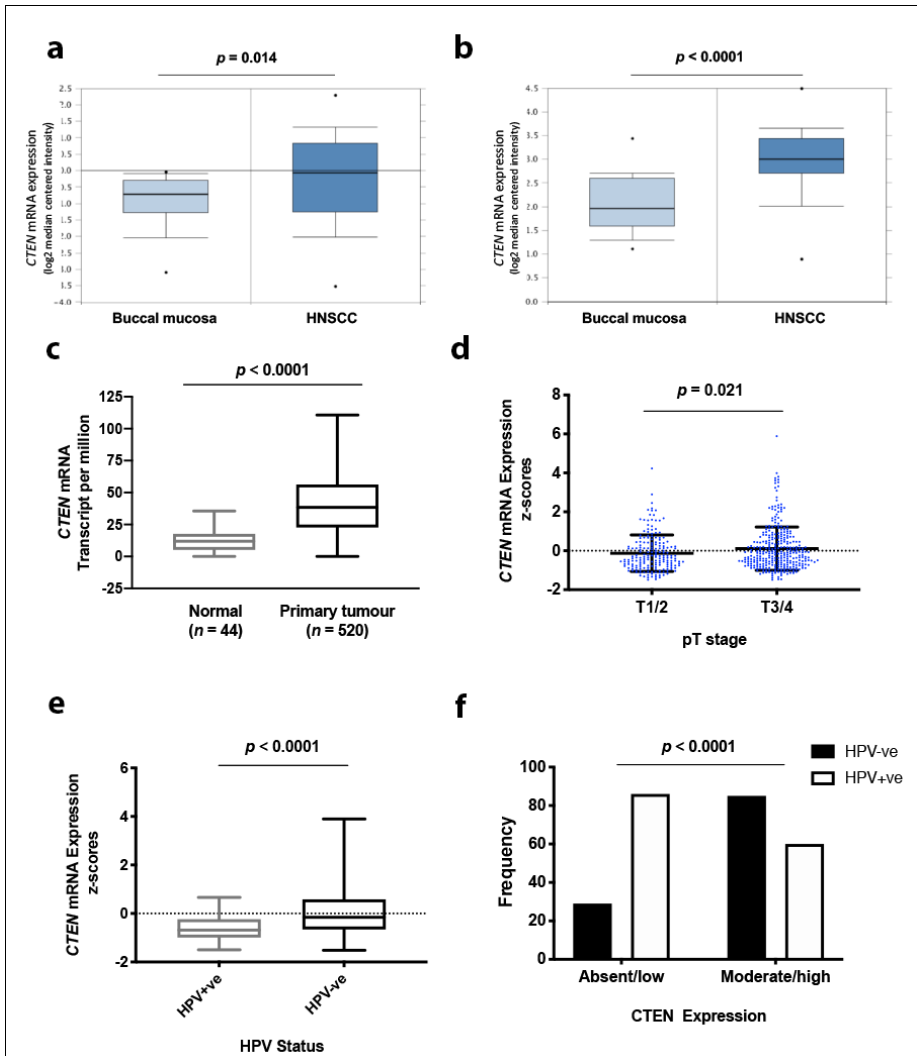
Figure 1. C-terminal tensin-like (CTEN) expression in head and neck squamous cell carcinoma (HNSCC) databases. mRNA expression levels of CTEN were significantly higher in head and neck cancer than in normal tissue across databases, as illustrated in boxplots including the ( a ) Ginos Head-Neck ( n = 54), ( b ) Peng Head-Neck ( n = 79) and ( c ) The Cancer Genome Atlas ( n = 564) datasets. Subgroup analysis of tumour samples in The Cancer Genome Atlas (TCGA) ( n = 520) demonstrates higher CTEN expression in advanced T-stage compared with early stage disease ( d ) and in human papillomavirus (HPV) − ve ( n = 243) compared with HPV + ve disease ( n = 36, [ e ]). Box plot length indicates min. to max. range and central line for the mean value and p -values (Student’s t -test) indicated above the graphs. ( f ) Immunohistochemical analysis of our oropharyngeal squamous cell carcinoma database ( n = 259; HPV − ve n = 113; HPV + ve n = 146) corroborates a greater CTEN protein expression in HPV − ve tumour specimens (Chi squared, χ 2 =